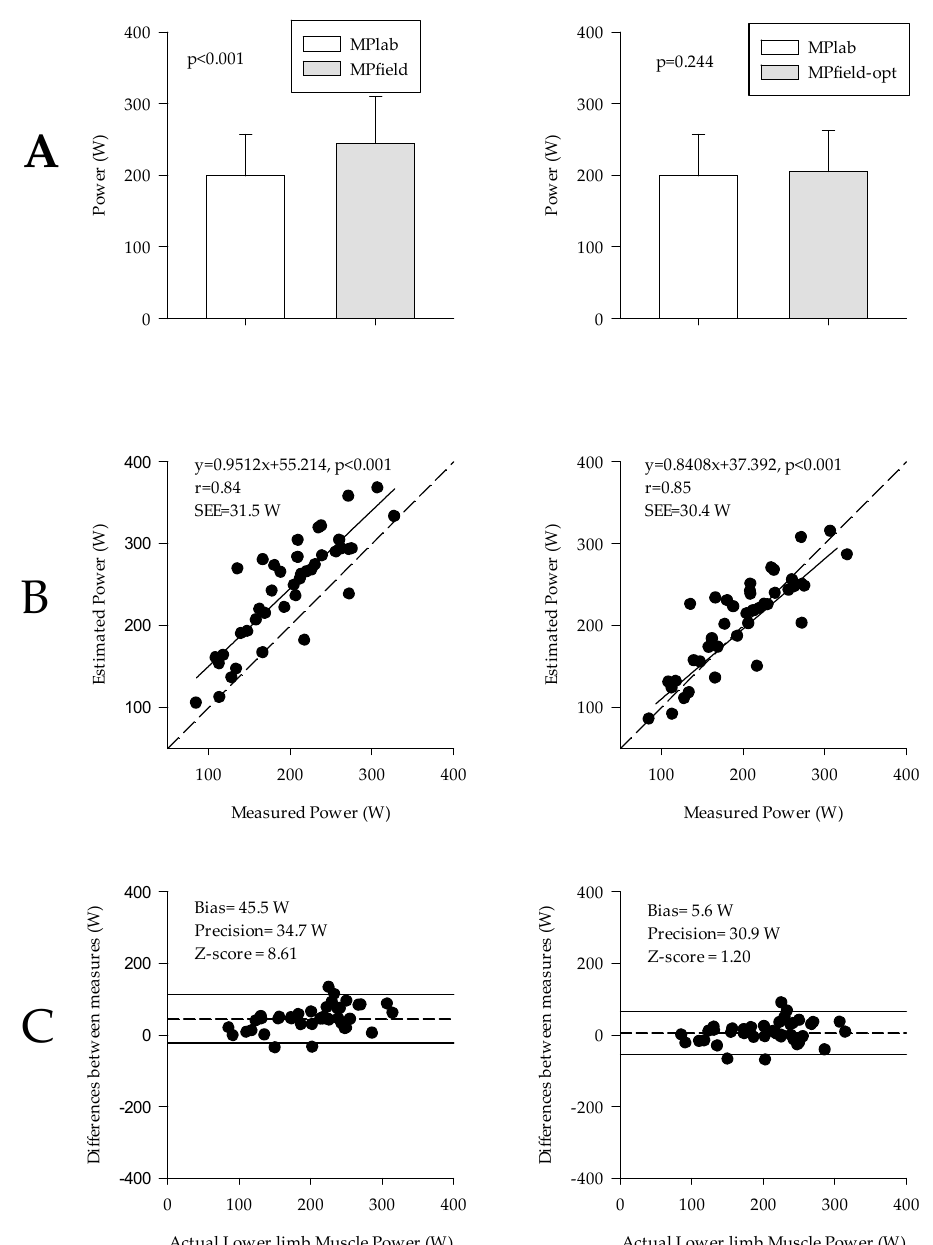
Figure 4. On the left side of the figure, we reported the comparison of means, correlation graph and Bland–Altman analysis referred to the Alcazar’s method vs. Laboratory method. On the right side of the figure, we reported the same panels referred to the Alcazar’s method with modified assumptions vs. Laboratory method. Panel ( A ): Comparison between estimated vs. measured mean values of lower limb muscle power. p -values are reported. Panel ( B ): Relationships between estimated vs. measured values of lower limb muscle power. Equation, p -value, Pearson’s correlation coefficient (r), and SEE are reported along with regression (solid line) and identity (dashed line) lines. Panel ( C ): Individual differences between measured and estimated lower limb muscle power are plotted as a function of the mean of the two. Bias (i.e., the mean difference between measures; dashed lines) and precision (i.e., limits of agreement; solid lines) are displayed along with numerical values and the results of the one-tail z test on the